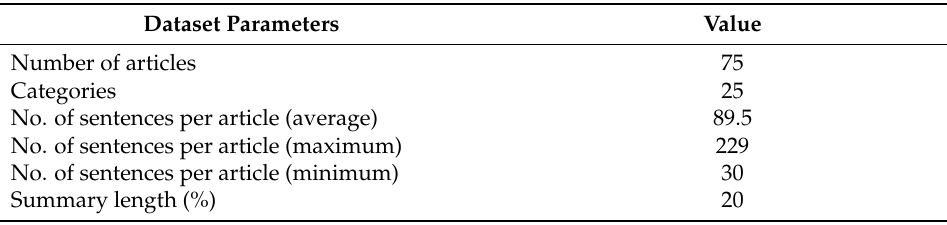
Table 1. Characteristics of the